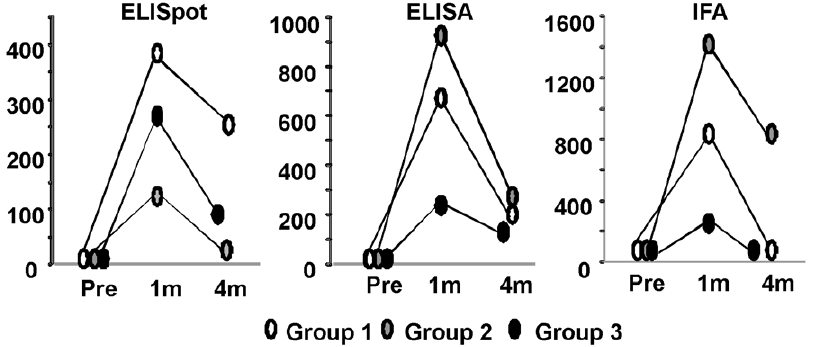
Figure 8. Comparing Groups 1, 2 and 3 for Immune Outcome Measures. The geometric means of ELISpot assay (CSP), ELISA (CSP) and IFA (sporozoite) in Groups 1, 2 and 3 are shown pre-immunization (Pre) and 1 and 4 months post immunization (1 month and 15 weeks post first immunization for Group 3). Groups 1 and 3 had better ELISpot responses than Group 2 (high dose), while Group 2 had the better ELISA and IFA responses (see Sedegah et al). Combination of the vector encoding CSP with the vector encoding AMA1 (Group 1) may have improved responses to CSP relative to the vector encoding CSP administered alone (Group 3), as immune responses were higher in Group 1 than in Group 3 for the three immune measures.